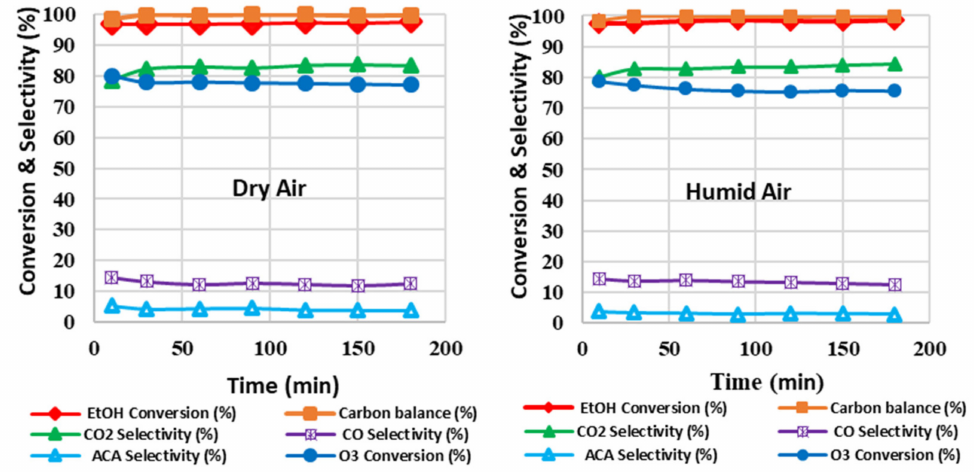
Figure 5. Ethanol conversion, ozone conversion, products selectivity and carbon balance as a func- tion of time on stream in dry ( left ) and humid ( right ) conditions (catalyst = 20 mg, total flow rate = 500 mL · min − 1 , [EtOH] = 10 ppm, [O 3 ] = 70 ppm, T = 60 ◦ C) for the palladium-doped catalyst (0.5Pd–5Mn/TiO 2